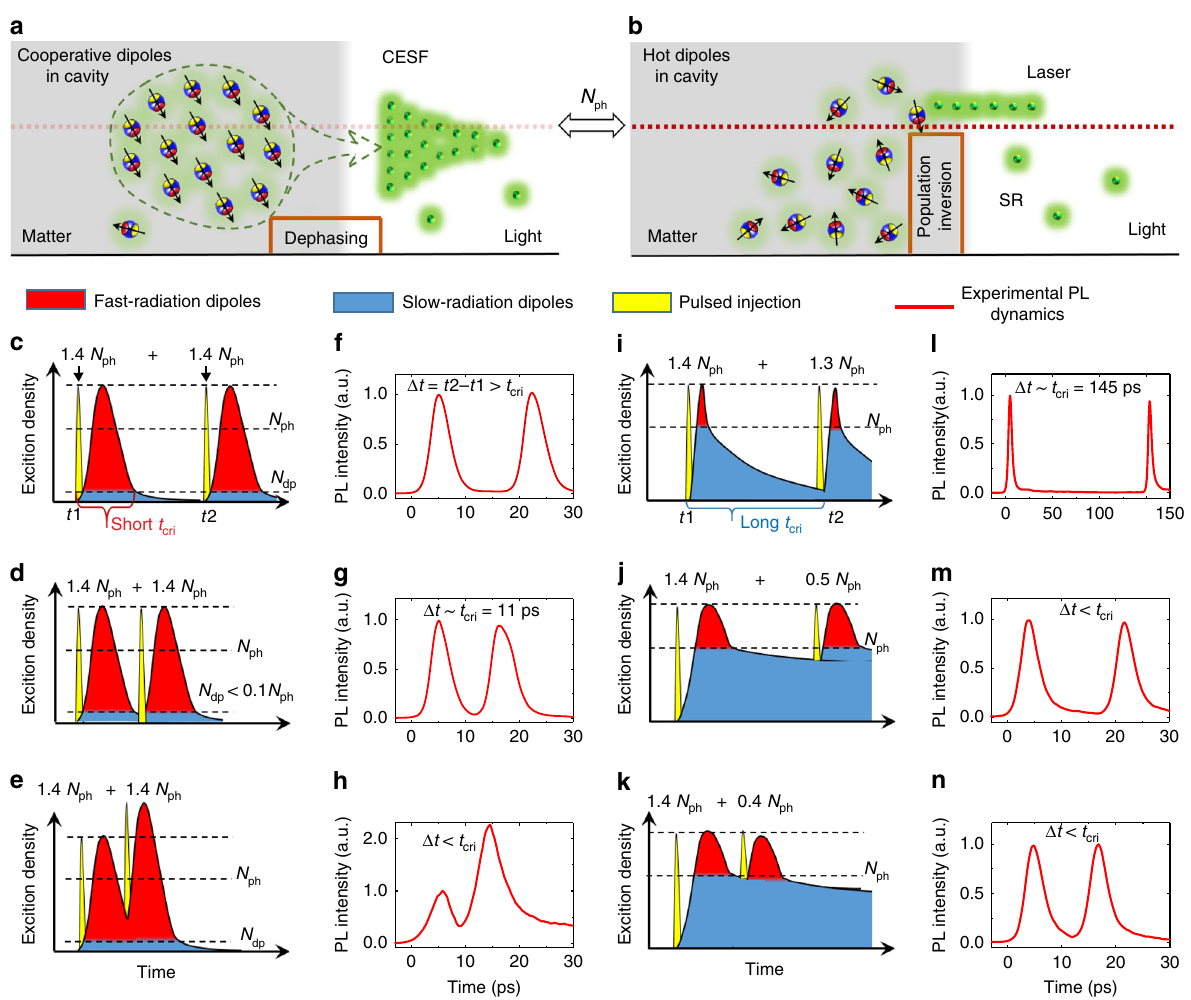
Fig. 4 Surplus dipoles after the CESF process vs. the case of a classical laser. a , b Sketches of cooperative (hot) dipole ensembles in optical cavities. SR means spontaneous radiation. c – e , i – k Dynamics of exciton density in a cooperative (hot) dipole system. The classical lasing process ends at the density level N ph , and CESF is limited by the small dephasing density N dp . f – h , l – n Experimental PL dynamics in the corresponding system. The PL intensity is normalized by that of the fi rst pulse. The critical time t cri of cooperative quantum excitons is much shorter than that of a hot exciton ensemble. The threshold density N ph for the QDSM sample and that for the classical lasing sample is about 70 and 50 μ J cm − 2 , respectively.